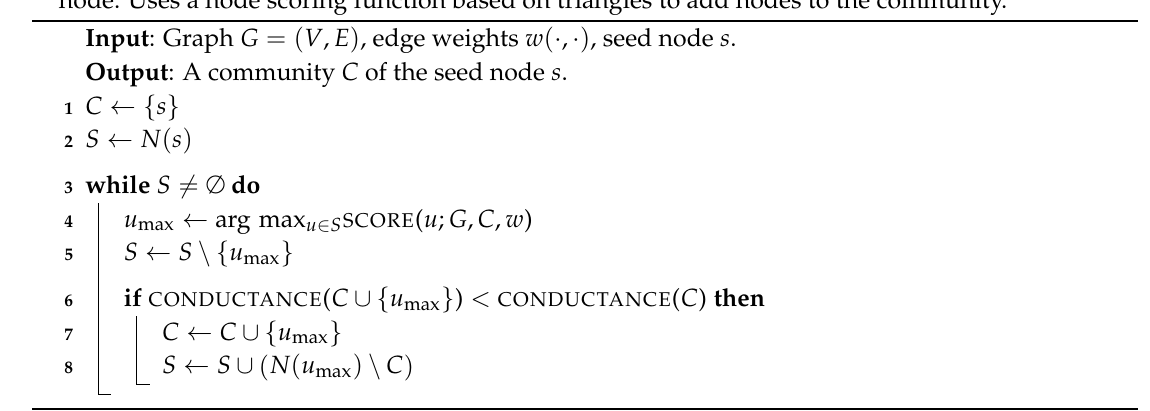
Algorithm 1: Triangle Based Community Expansion (TCE) detects a community around a given node. Uses a node scoring function based on triangles to add nodes to the